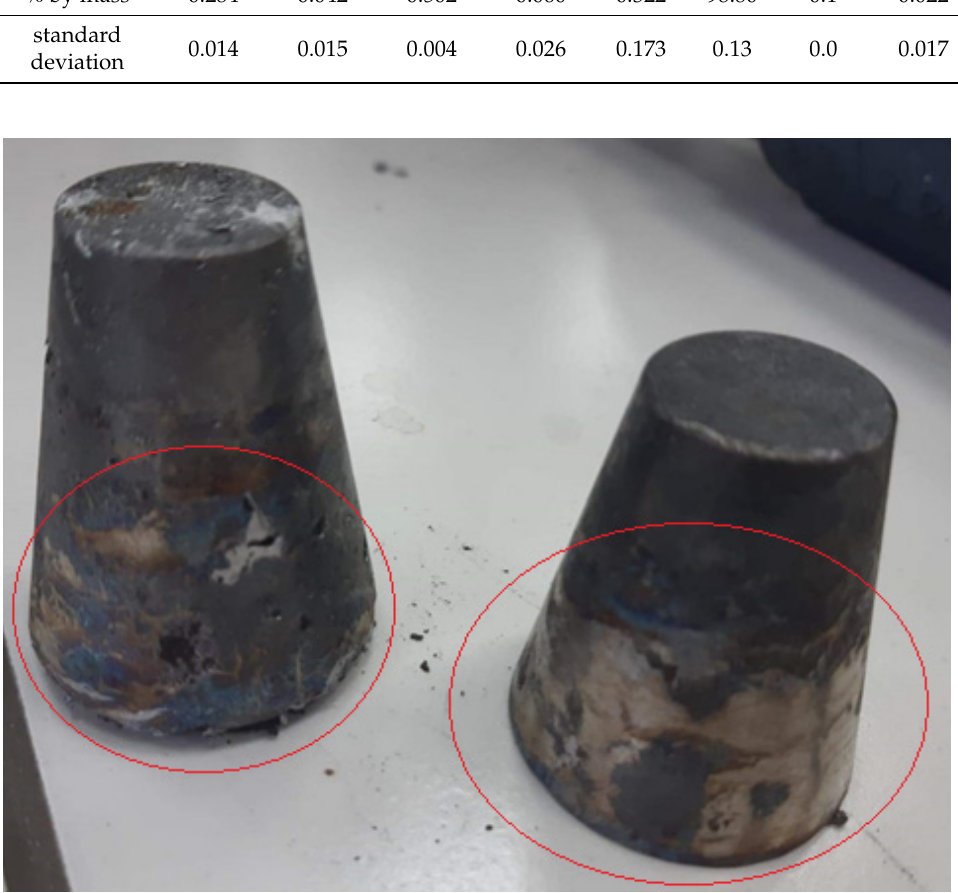
Figure 5. Appearances of ingots after pouring molten lead with PCB, red circles show a colorization of ingots . Table 4. Chemical compositions of the lead ingots after melting with PCB pyrolyzate “B1”, aver- ages and standard deviation of 3 analyses.